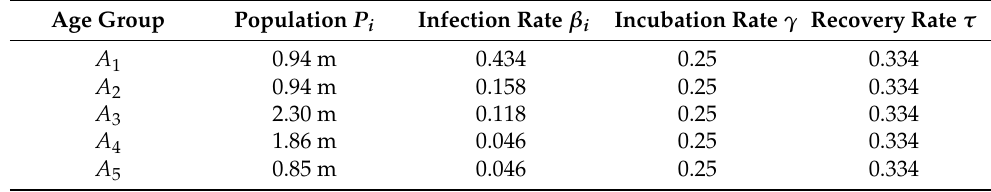
Table 7. Parameters of 2009 Hong Kong’s H1N1 epidemic.